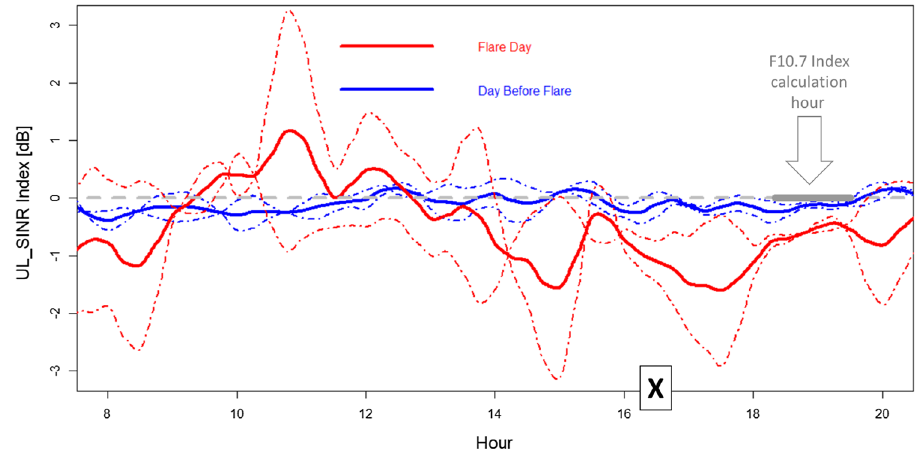
Figure 5. Full day comparison between the UL_SINR Index (derived from MDT radiomobile measures in 2.6 GHz band) during July 3rd (red line) and during the day before (blue line), with more quiet Sun. The dotted and dashed lines indicate the standard deviation (in blue for July 2nd, red for July 3rd) of the two UL_SINR distributions (whose medians are the two compared UL_SINR indexes) describing the UL_SINR difference between Sun-oriented and non-Sun-oriented cells. “X” indicates the flare peak in X-ray emission (local Italian time, UT + 2H). The thick gray segment (see gray arrow), along the dotted gray lines (indicating UL_SINR Index zero), shows the hour of the, a 60-min period of minor solar emission at 2.8 GHz and lower solar emission difference between the two consecutive